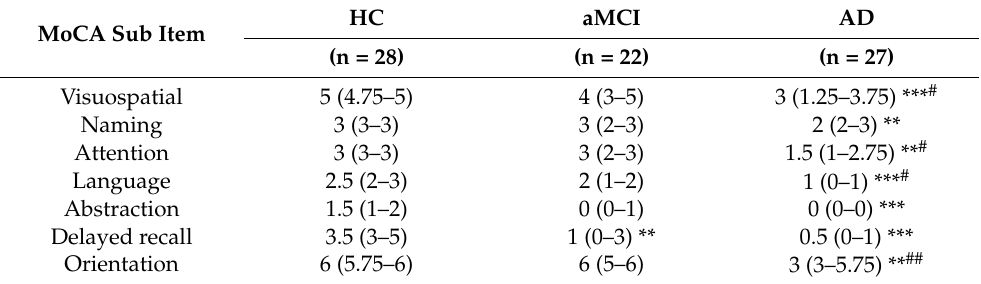
Table 2. Sub item Montreal Cognitive Assessment (MoCA) scores of AD, aMCI, and HC groups. MoCA Sub